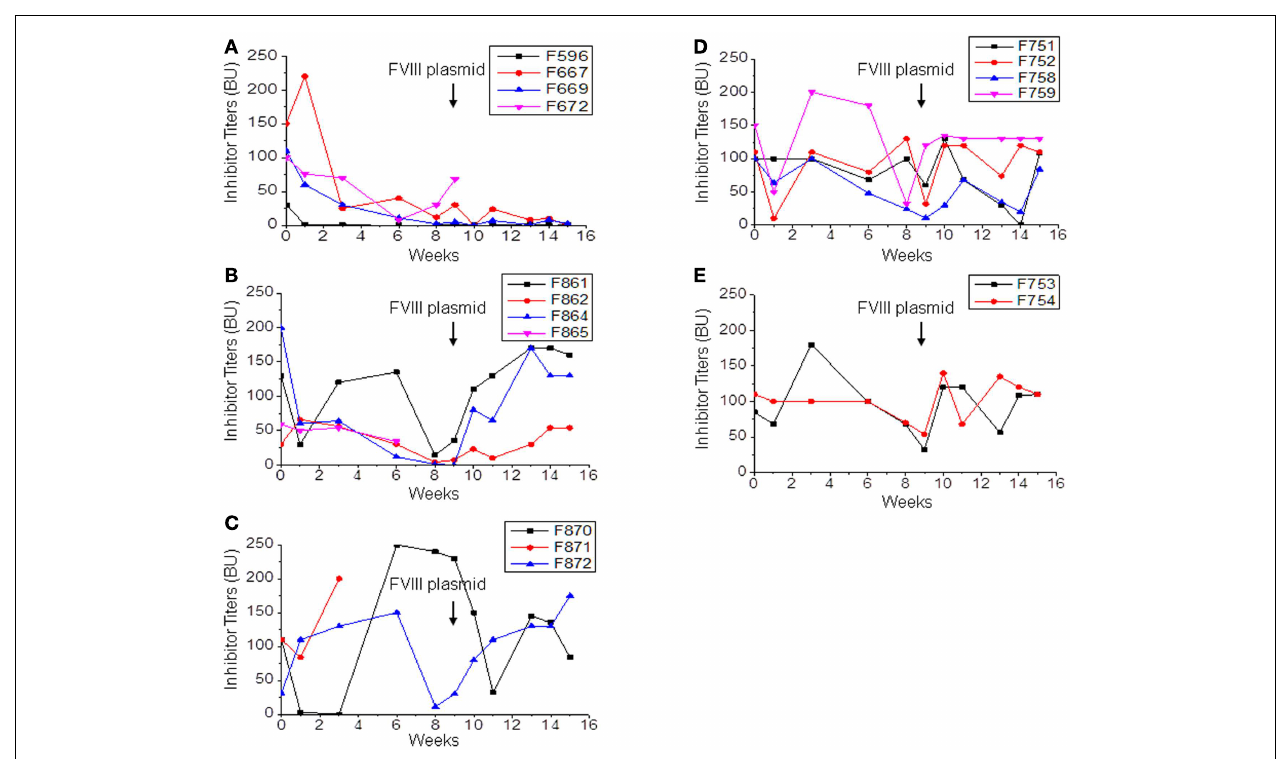
complexes + rapamycin + FVIII injection ( n = 3, group 3), (D) anti-CD20 + FVIII injection ( n = 4, group 4), and (E) Control inhibitor mice ( n = 2, group 5). Each experimental group was treated with indicated immunomodulation regimen weekly for 4weeks. Anti-FVIII antibody titers were assessed by Bethesda assay over time. Each symbol represents data obtained from an individual mouse. Data shown is representative of three independent